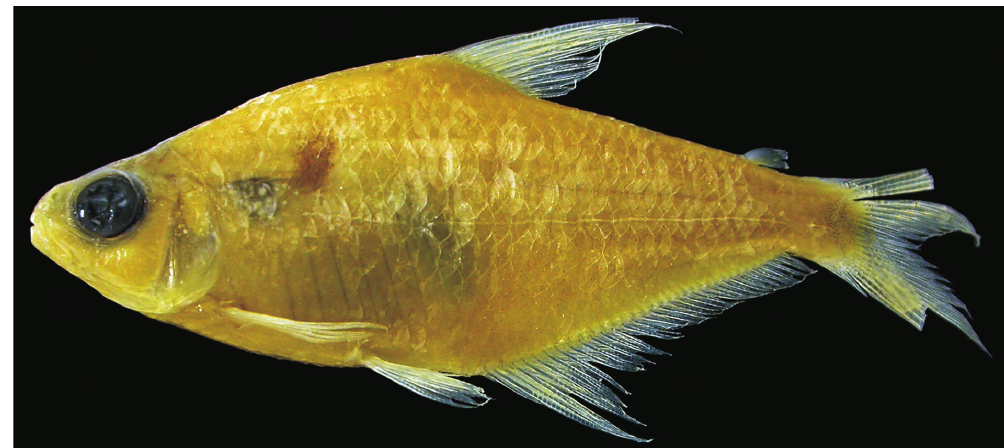
Figura 4. Phenacogaster maculoblongus sp. nov. , MBUCV-V-30230, holótipo, 45,4 mm CP, caño Caballepe, Venezuela.